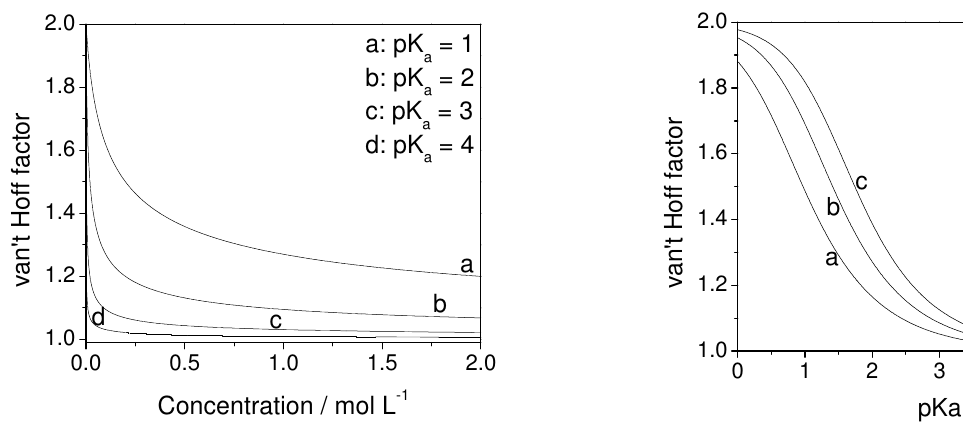
Fig. 7. Van’t Hoff factor as a function of concentration (calculated according to Eq. 3) for four monovalent acids with different pKa- values.